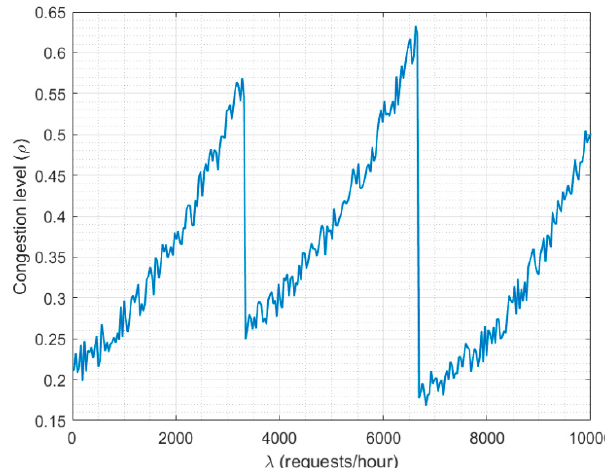
Figure 10. Third experiment: congestion level.